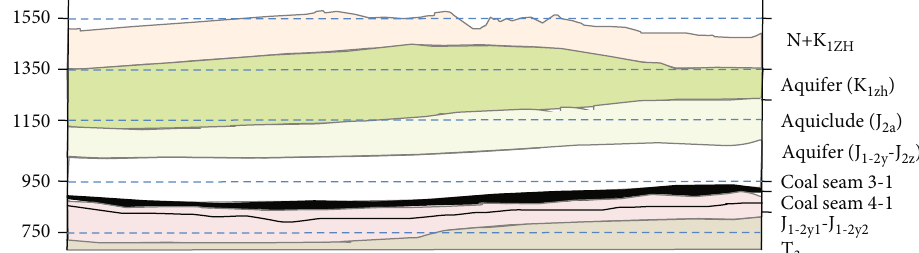
Figure 2: Hydrogeology condition of the coal and uranium reservoir.